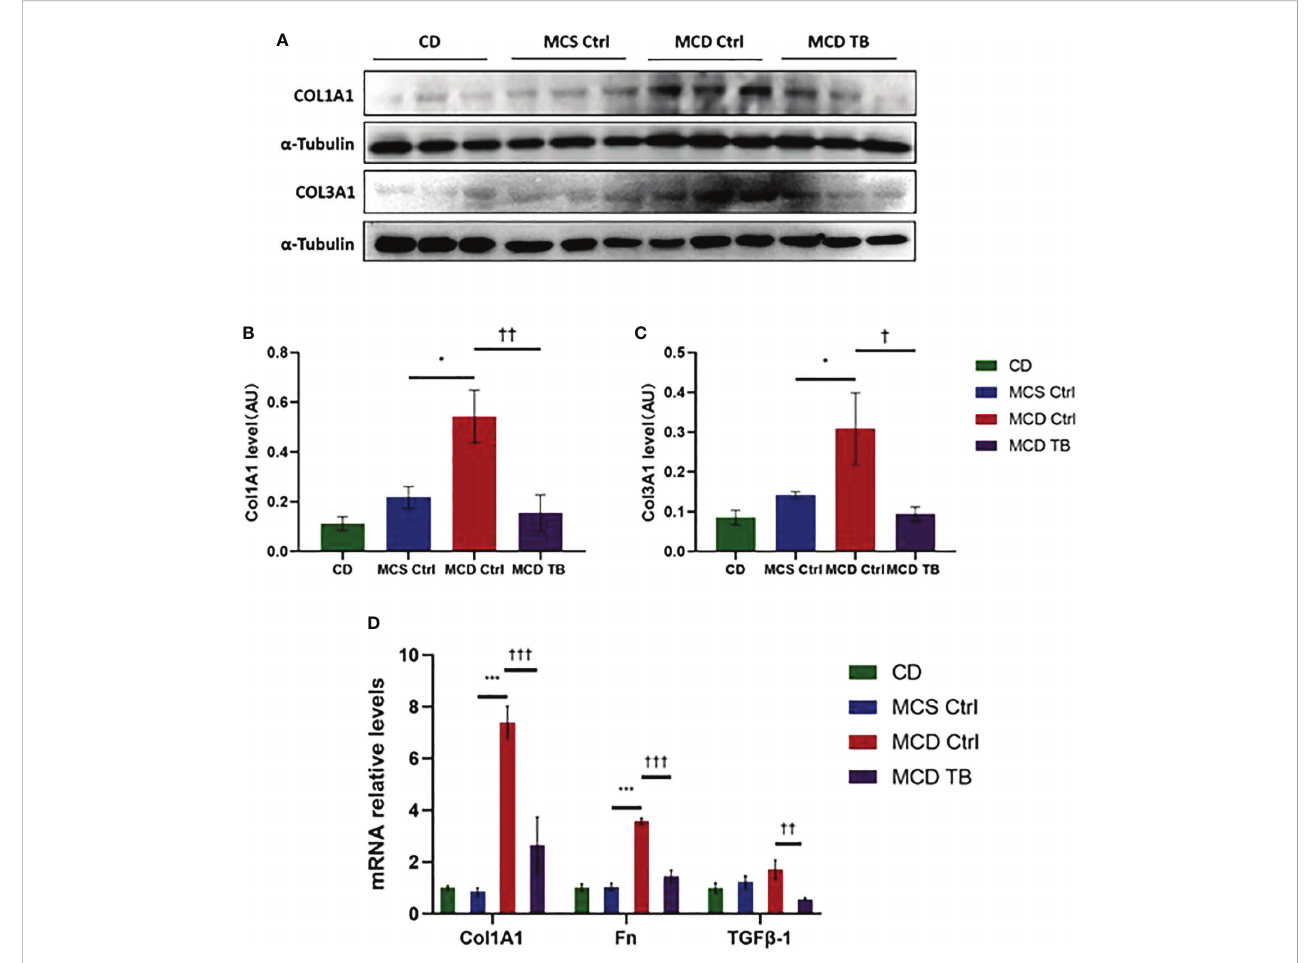
FIGURE 6 Theabrownin reduces hepatic levels of collagen and glycoprotein in MCD diet-fed mice. (A) Protein levels of COL1A1 and COL3A1. (B) Quanti fi cation of COL1A1 level. (C) Quanti fi cation of COL3A1 level. (D) mRNA levels of COL1A1, Fn, and TGF b -1. AU, arbitrary units. n=5-11 mice per group. The data are mean ± s.e. (error bars). *p < 0.05, ***p < 0.001, MCS Ctrl vs. MCD Ctrl. † , p<0.05, †† , p<0.01, ††† , p<0.001 MCD Ctrl vs. MCD